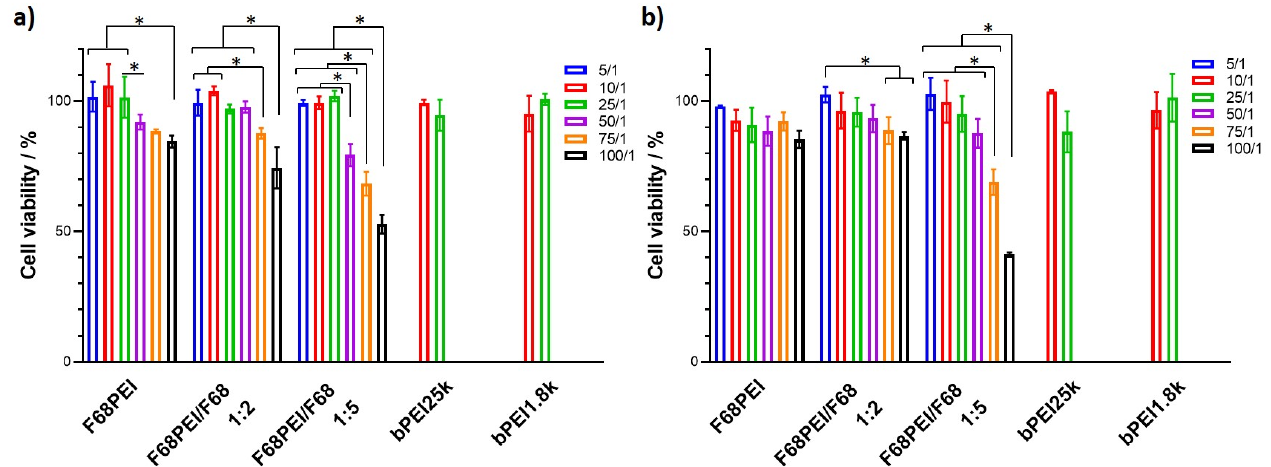
Figure 4. Cell viability of ( a ) SCC-9 and ( b ) U2OS cells exposed to polyplexes prepared with different F68PEI formulations: F68PEI, F68PEI/F68 1:2 and F68PEI/F68 1:5. Cells were exposed to the formulations for 4 h and analyzed after an additional 48 h. Data are expressed as the percentage of cell viability with respect to the control (nontreated cells) and shown as the mean ± standard deviation. * Statistically different groups ( p < 0.05).